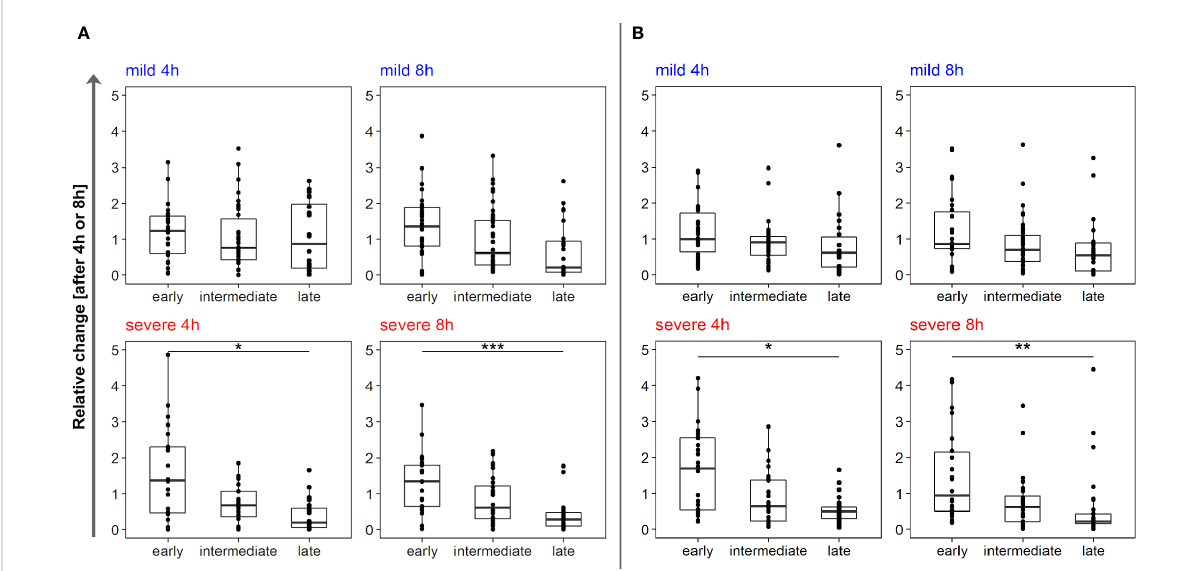
FIGURE 4 Outcome of competitive fi tness experiments in mPCLS and hPCLS after 4 h and 8 h. Serial P. aeruginosa isolates from mild courses (upper panel) and severe courses (lower panel) were grouped by colonization time in CF patients ’ lungs time in early, intermediate and late isolates (see Supplementary Tables S4/S5 for details). Relative growth changes are shown for the individual strains of the three groups. The number of data points per group depends on the number of isolates assigned to that group. Since early/late isolates were assigned to the fi rst/last quartile of the infection period, respectively, the intermediate isolates extend to the inner two quartiles and are therefore quantitatively superior. Statistics and thus the signi fi cance were calculated with the help of Kruskal-Wallis. All p- values were corrected for multiple testing by Bonferroni